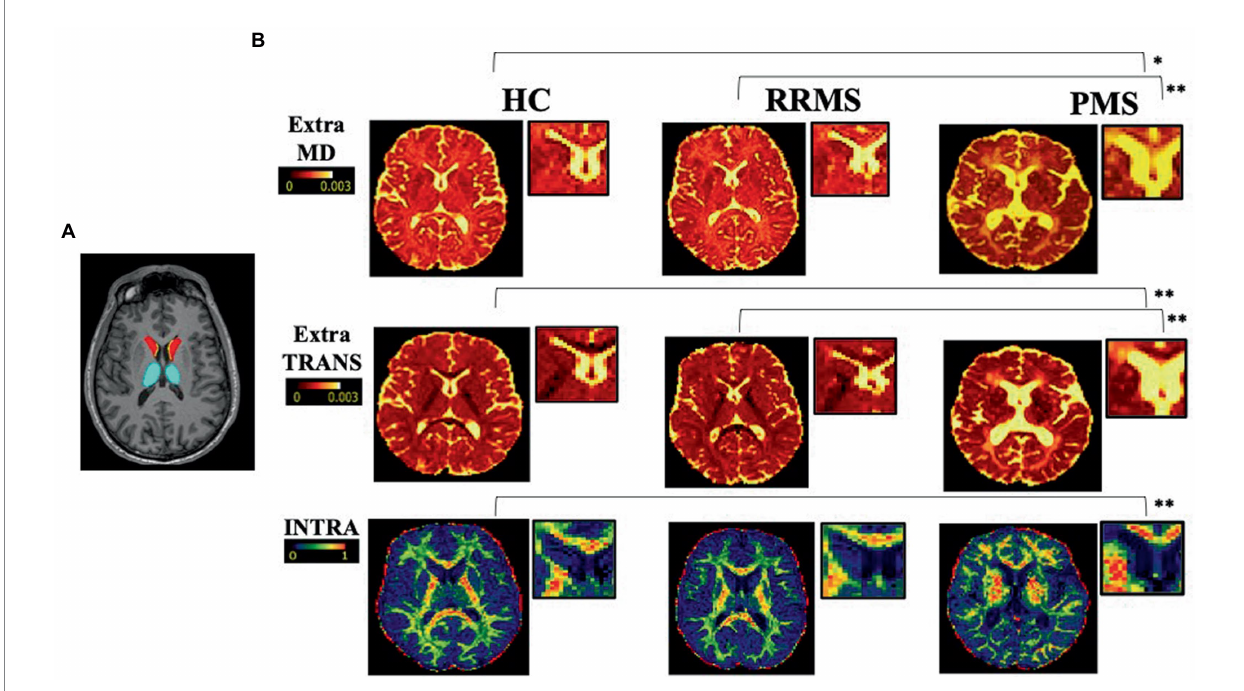
FIGURE 1 Selected examples of axial slice in a healthy control, a RRMS and a PMS patient. On the left (A) a selected axial slices from T1-weighted image showing segmented masks of SVZ (yellow), caudate (red), and thalamus (light blue). On the right (B) representative axial slices of EXTRAMD (top; 10–3 mm 2 /ms), EXTRATRANS (center; 10–3 mm 2 /ms), and INTRA (bottom) maps in a HC, a RRMS and a PRS patient. *; ** p -values referring to the analyses performed on the global population (* p < 0.5 and ** p < 0.01). HC = healthy control; RRMS = relapsing–remitting multiple sclerosis; PMS = progressive multiple